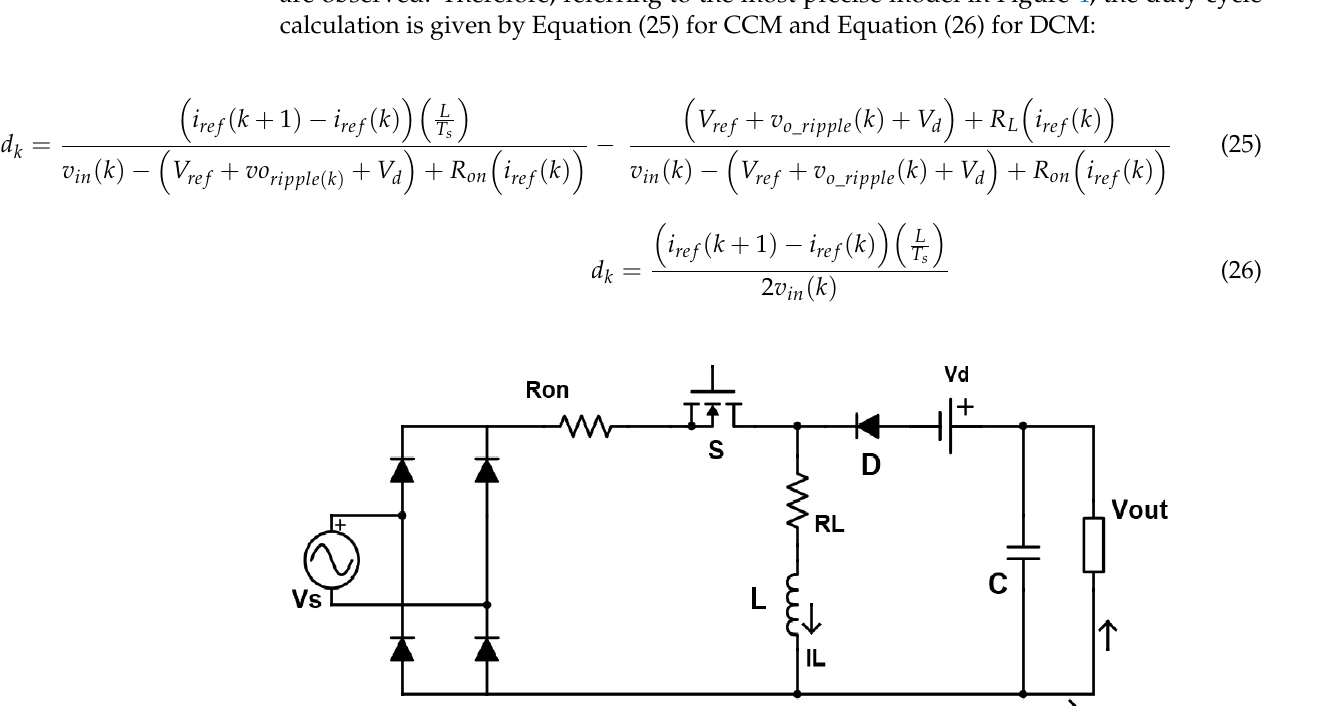
loops: the voltage control loop (outer loop) and the current control loop (inner loop). Feedback signals in this feedforward control are v o and v in